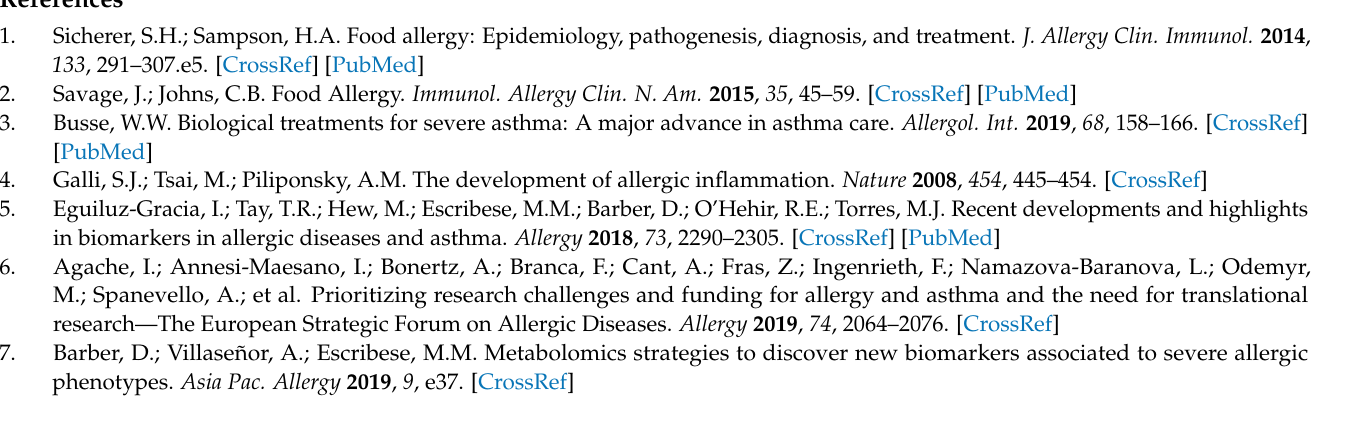
HILIC method; Figure S2: Chromatographic profile for reversed-phase method; Table S1: Selected metabolites from non-targeted metabolomics studies; Table S2: Complete clinical information of patients recruited in the study; Table S3: Pairwise comparisons showing the significance of metabolites among study